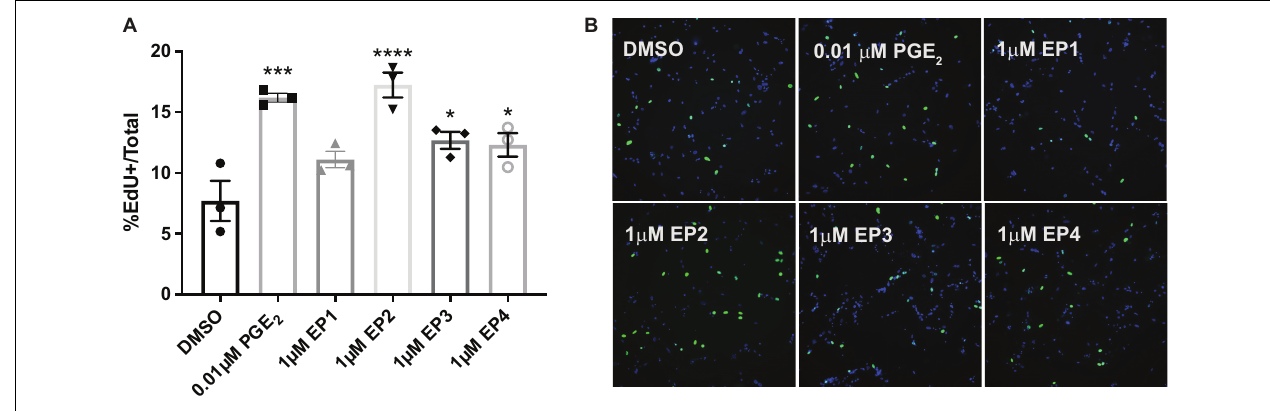
FIGURE 4 | PGE 2 and EP2, 3 and 4 receptor agonism induce proliferation of primary parotid gland cells. Primary parotid cells were prepared from C57BL/6J mice, serum-starved for 2 h and treated with vehicle (DMSO), PGE 2 (0.01 µ M) or the EP receptor-selective (EP1R-EP4R) agonists for EP1R: 17-phenyl trinor PGE 2 (1 µ M), EP2R: AH13205 (1 µ M), EP3R: sulprostone (1 µ M) or EP4R: CAY10598 (1 µ M). All compounds were solubilized in DMSO, mixed with serum-free primary cell culture media and incubated with cells for 24 h with EdU added during the last hour of treatment to monitor proliferating cells, as described in section “Materials and Methods.” (A) Groups were quantified by averaging the number of positive cells out of the total number of cells from 5 fields of view/slide. Graphs represent the mean ± SEM. Each symbol represents an independent sample. Significant differences from DMSO-treated cells were determined via a one-way ANOVA followed